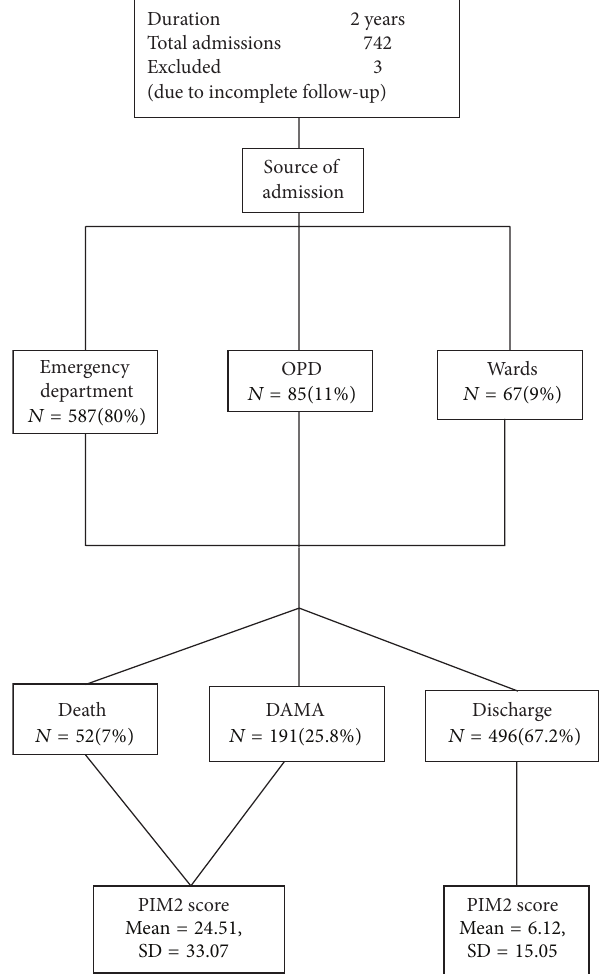
Figure 1: Flowchart of study participants. OPD: outpatient department, DAMA: discharge against medical advice, PIM2: pediatric index of mortality 2, and SD: